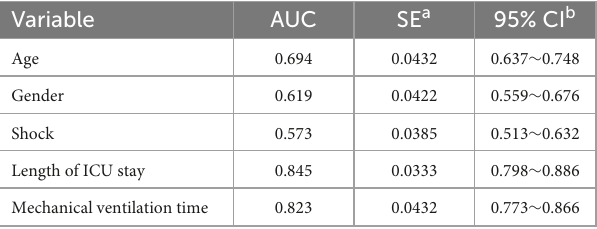
TABLE 8 The area under the curve of each predictive variable in the